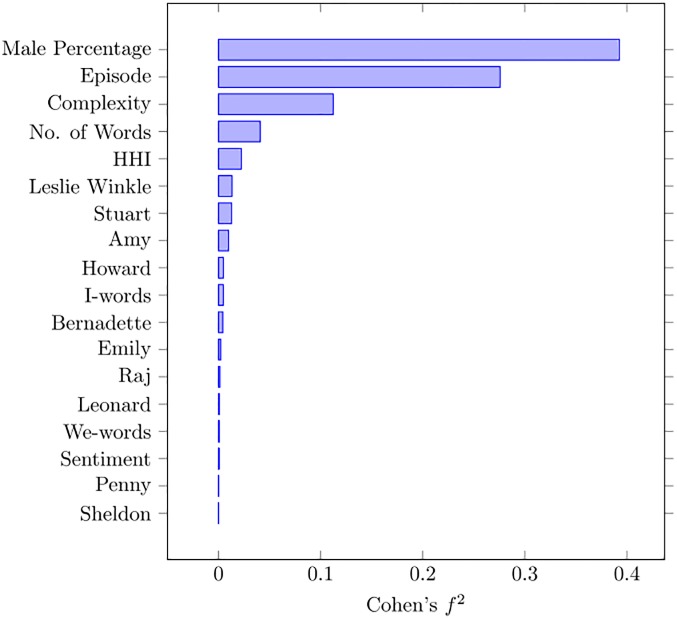
Cohen’s f2 for voters.